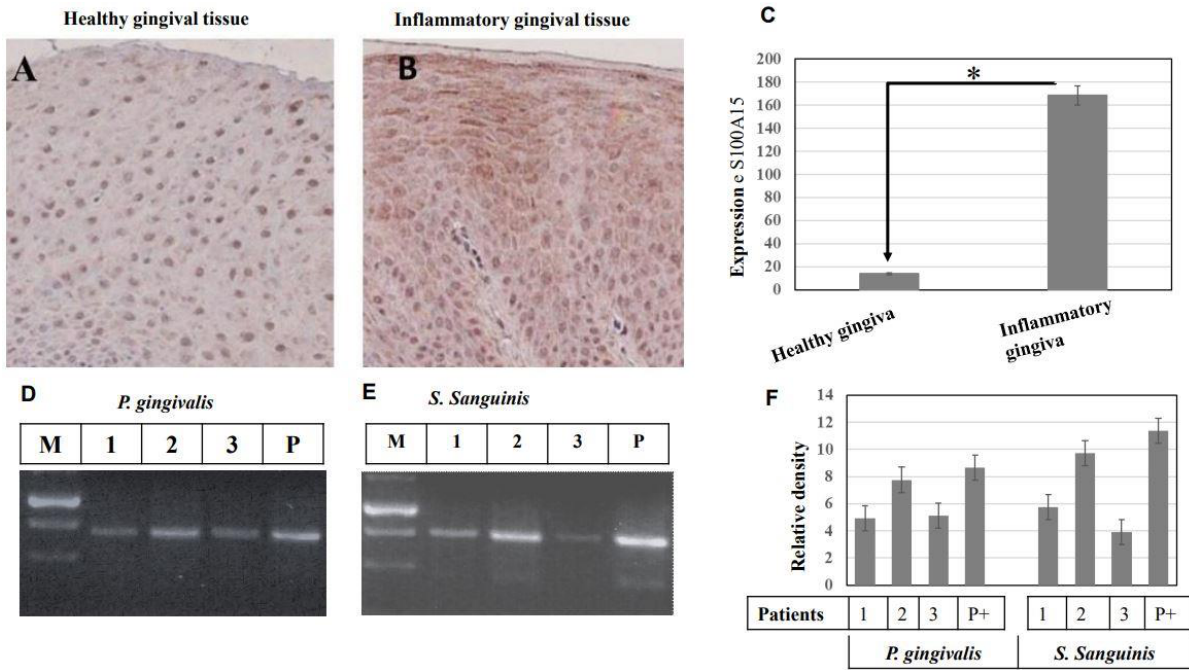
Figure 7. Immunohistochemical analysis of S100A15 protein in oral mucosa of patients with inflammatory gingiva. ( A ), Gingival tissues of healthy individuals (n = 10) were stained with anti-S100A15 antibodies. ( B ) Gingival tissues of patients with inflammatory gingiva (n = 10) were stained with anti-S100A15 antibody. Original magnification × 100. Scale bar indicates 100 μm . ( C ) Statistical Analysis of S100A15 expression in gingival tissues of patients with inflammatory gingiva (n = 10) as a relative ratio to the expression of S100A15 in gingival tissues of healthy individuals. Bars represent mean ± SD from inflammatory (n = 10) and healthy (n = 10) gingival tissues, * p < 0.05. ( D , E ) Detection of oral bacterial pathogens (gram − P. gingivalis and gram + S. sanguinis ) in the saliva of patients with inflammatory gingiva by conventional PCR. Detection of both P. gingivalis and S. sanguinis in the saliva of patients with inflammatory gingiva by PCR. The PCR was performed using specific primers to amplify a 480 bp fragment of the 16S rRNA gene as a marker for P. gingivalis the UDP-N-acetylglucosamine-like protein gene as a marker for S. sanguinis ( E ). PCR products were separated on 2% agarose and stained with ethidium bromide. ( F ) Analysis of band intensity as the relative ratio of the amplified DNA fragment of 16S rRNA gene, the marker of P. gingivalis, and the amplified of the UDP-N-acetylglucosamine-the marker of S. sanguinis to the corresponding positive control. Bars represent the mean ± SD from three blots, * p < 0.05. 3. Discussion In this study, we demonstrate for the first time that induction of S100A15 in the oral mucosa is attributable to the colonization of both gram − and gram + bacteria in the oral cavity and provide insight into the mechanisms which are implicated in the transcriptional regulation of S100A15 protein in the oral mucosa. Although many AMPs, including S100A15, have been reported in several studies for their contributing role in host innate immunity, particularly in herpes simplex virus-and Epstein-Barr virus-infected oral mucosa [26,27], the mechanisms of S100A15 in the innate immunity of oral mucosa, so far, is not discussed in detail. In the present study, we demonstrate for the first time that the induction of S100A15 expression in oral mucosa by either gram − ( P. gingivalis ) or gram + ( S. Sanguinis ) bacteria is mediated by TLR4 and TLR2, respectively. The stimulation of both TLR4 and TLR2 signals by either gram − or gram + bacteria is mediated via TRAF6, leading to the activation of NF- κ B and ASK1-JNK-AP-1 and ASK1-p38-ATF-2 pathways to induce the expression of S100A15 in the oral mucosa. These findings indicate that the production of antimicrobial proteins (AMPs) such as S100A15 by the epithelial cells in oral mucosa